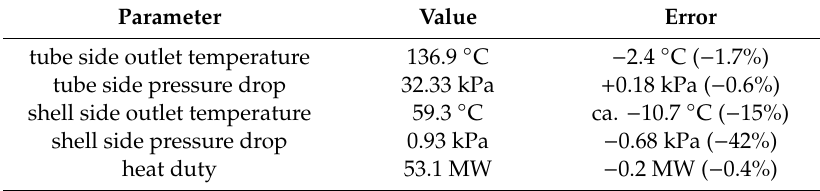
Table 4. Results obtained using HTRI Xchanger Suite and the corresponding errors compared to the data from the operator of the boiler. It is apparent that the temperatures and the tube-side pressure drop were predicted quite accurately, but the shell-side pressure drop was markedly below the measured value.